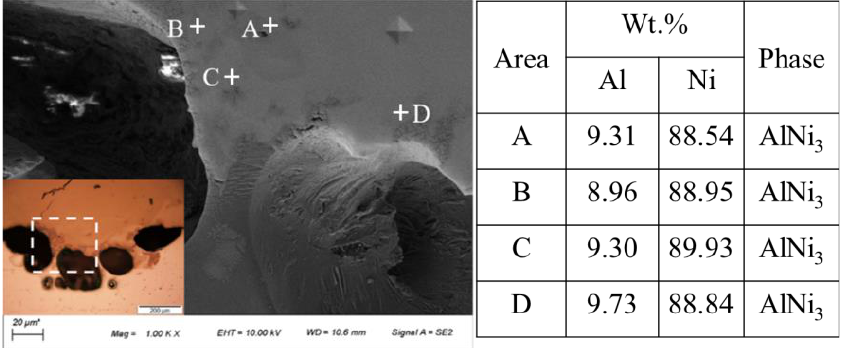
Figure 5. SEM image with high magnification, EDS results in areas A-D of the Al-Ni joint welded using PW laser with 150 W laser power.